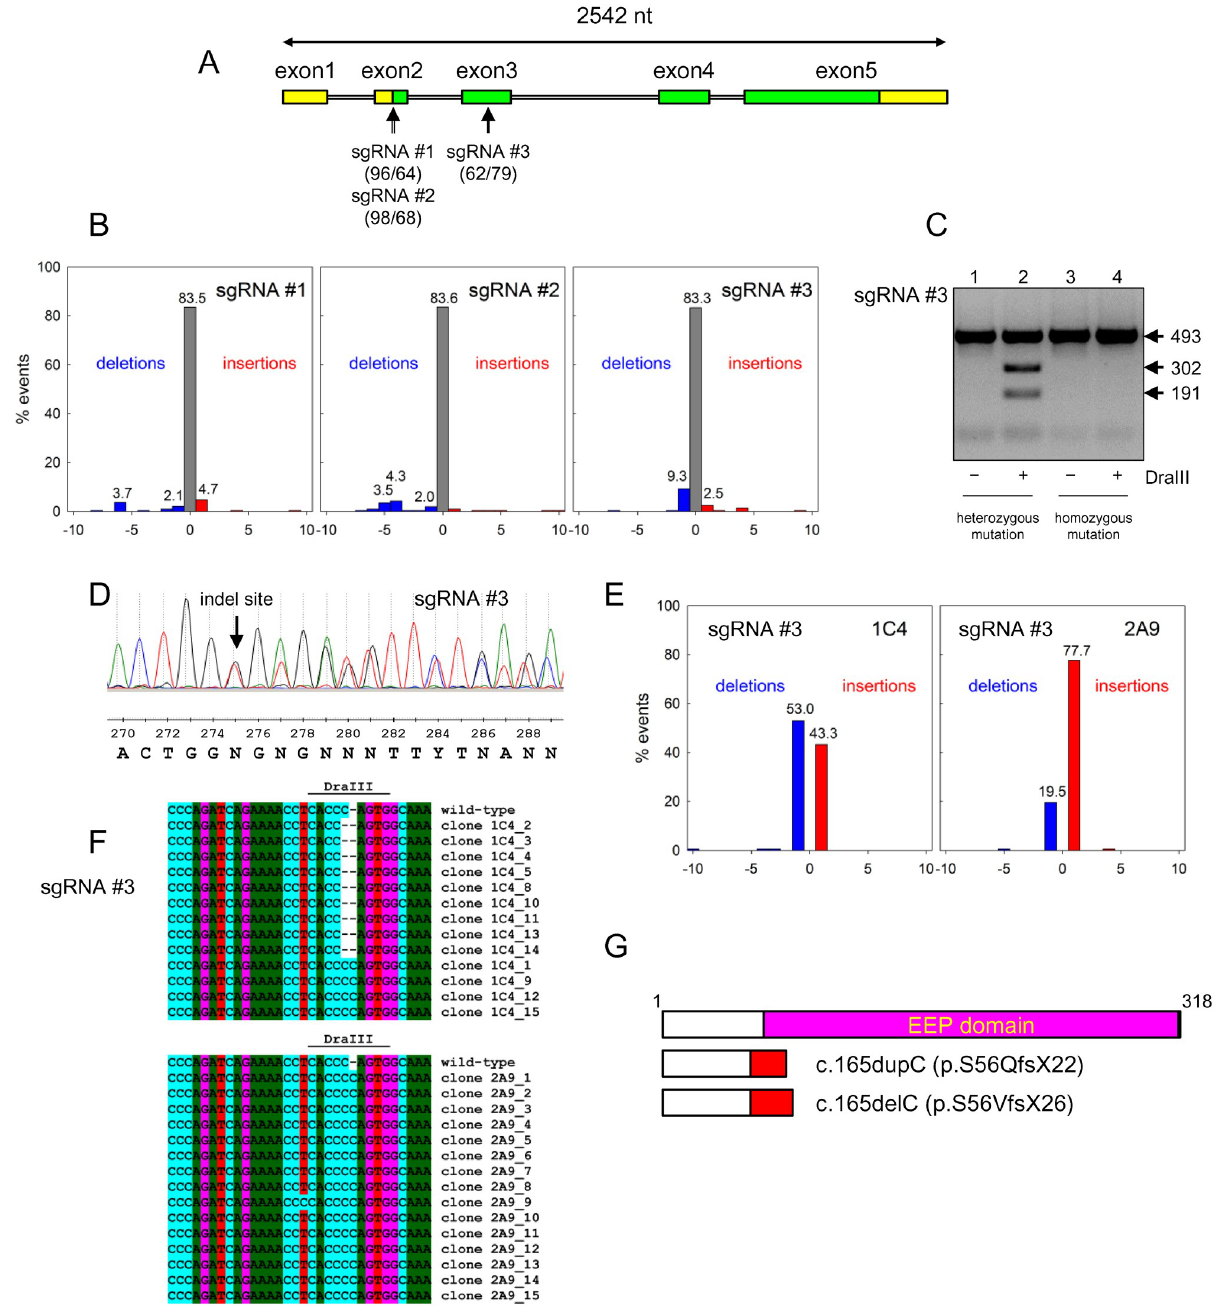
Fig 1. Generation of APEX1 knockout cells using CRISPR/Cas9 technology. A, map of human APEX1 gene and location of the protospacers targeted by sgRNAs. Numbers in parentheses correspond to efficiency and specificity scores calculated by benchling.com; higher scores indicate better efficiency and better specificity. Green parts of the exons correspond to the protein-coding sequence. B, TIDE analysis of the distribution of mutation events in the pool of HEK 293FT cells after transfection with pX458 expressing different sgRNAs. The blue bars represent deletions, the red bars, insertions, the grey bars, sequences with no mutations. The X axis shows the distance from the target cleavage site in nucleotides. C, cleavage of the PCR-amplified part of the APEX1 gene by DraIII in wild-type cells ( lanes 1 , 2 ) and after a successful knockout induced by sgRNA#3 ( lanes 3 , 4 ). Arrows mark the mobility of the full-length PCR product (493 nt) and the cleavage fragments. D, representative capillary sequencing chromatogram (ABI 3130xl instrument; complementary strand sequenced) of the PCR-amplified part of the APEX1 gene from the DraIII-negative clone 1C4. E, TIDE analysis of the distribution of mutation events in 1C4 and 2A9 single cell clones induced by sgRNA#3. F, sequences of the protospacer region in subcloned fragments from 1C4 and 2A9 cells. G, truncated APEX1 proteins arising from the single-base insertion and single-base deletion at nucleotide 165. Changed polypeptide parts after the frameshift are colored red. The catalytic EEP domain is shown in magenta.